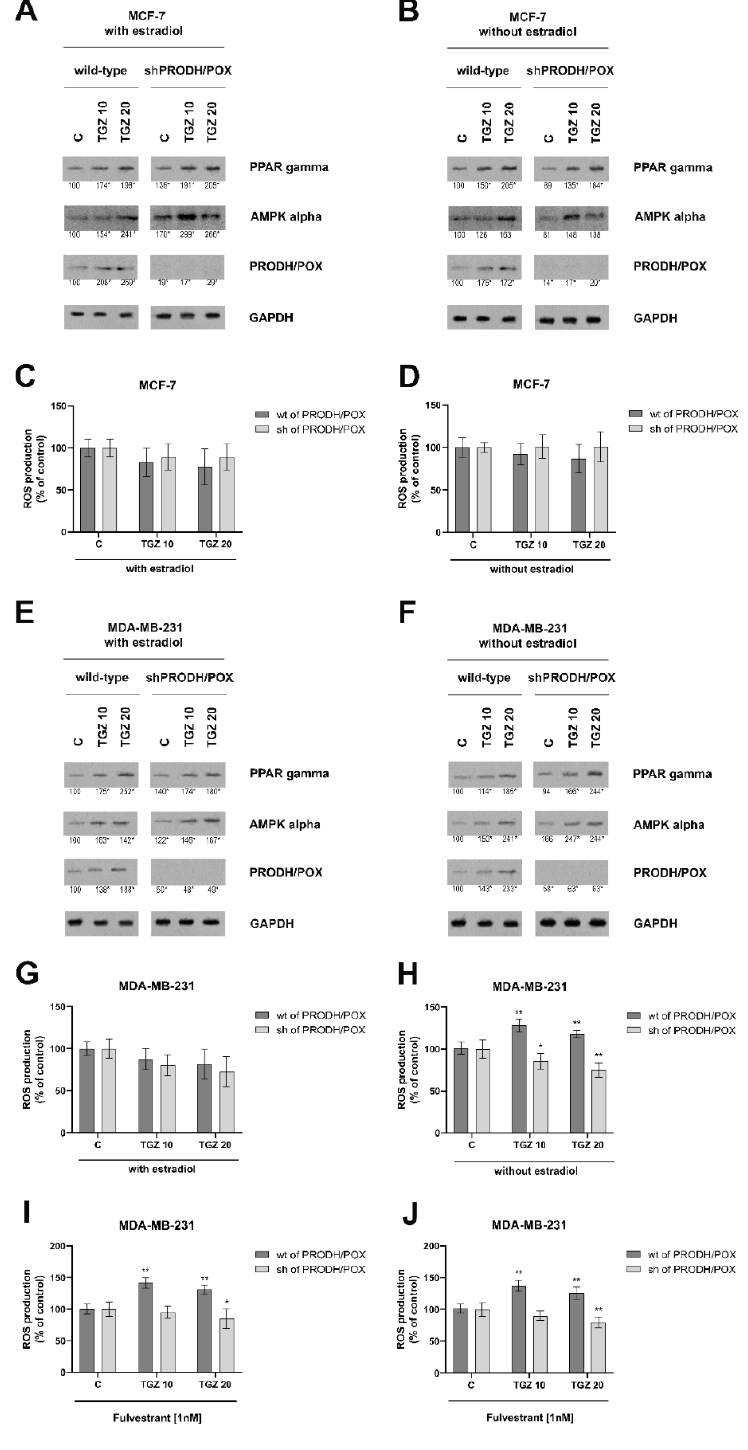
Figure 2. PRODH/POX, AMPK and PPAR- γ expressions in wild type (wt of PRODH/POX) and PRODH/POX-silenced (sh of PRODH/POX) MCF-7 and MDA-MB-231 cells treated for 24 h with troglitazone (TGZ) in the presence ( A , E ) and absence ( B , F ) of estradiol. Representative blot images were shown (the mean value of densitometric analysis of protein bands presented below each blot; * p < 0.01). Supplementary Materials contain statistical analysis of the evaluated proteins (Supple- mentary Material, Supplementary Figures S2–S7). ROS production is presented in wild type (wt of PRODH/POX) and PRODH/POX-silenced (sh of PRODH/POX) MCF-7 and MDA-MB-231 cells cul-